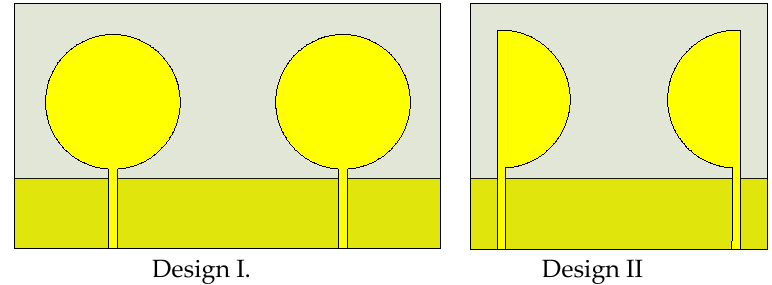
Figure 3. The design procedure of the proposed SWB multiple input multiple output (MIMO) antenna.